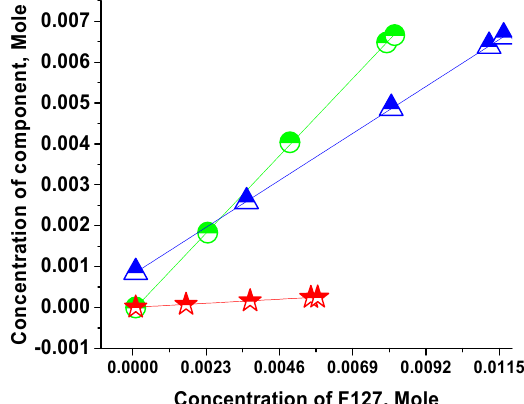
Fig. 9. Titration of solutions in PBS with component versus F127 pluronic: (star) Tocopherol drug, (circle) oil+drug (1:1 molar ratio), and (up triangle) oil and F127 surfactant. The solution is clear below the curve and turbid above the curve.